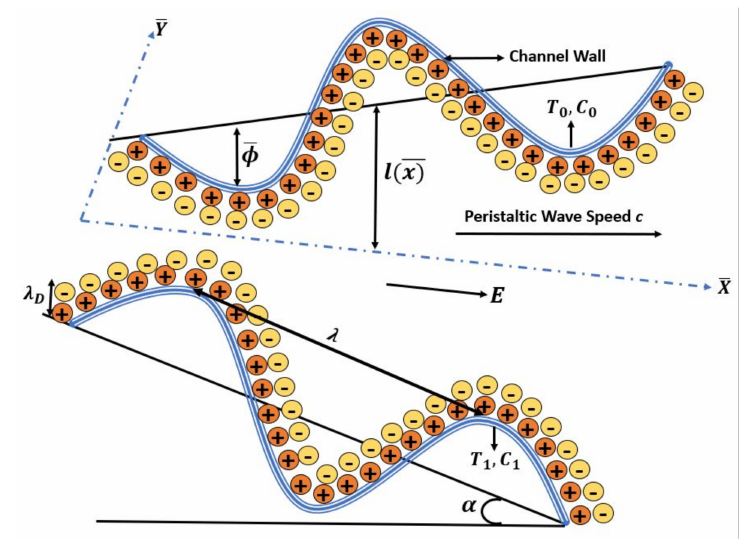
Figure 1. Flow channel